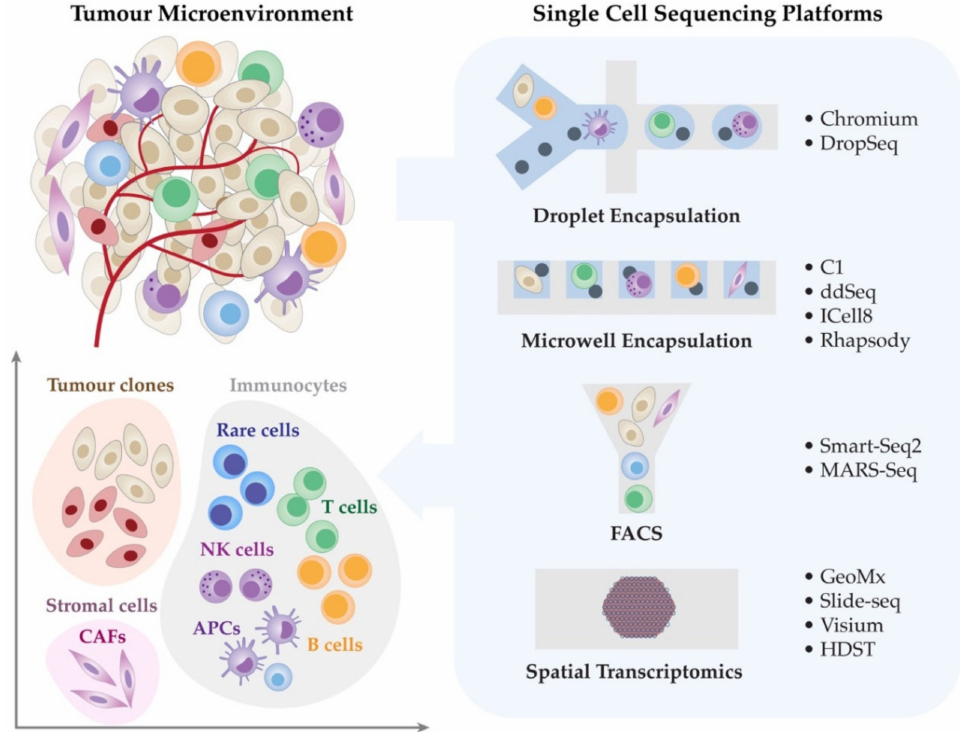
Figure 1. Single cell sequencing facilitates the dissection of the tumour microenvironment. The tu- mour microenvironment (TME), including malignant cells, immune cells and stromal cells, regulates a range of cellular and molecular signals. Such signals influence the cell states, tumour proliferation, host immunity and response to systemic therapies. Single cell technologies are providing unique opportunities for dissecting the orchestration of the TME and understanding the tumour-intrinsic and -extrinsic mechanisms of immunotherapy response and